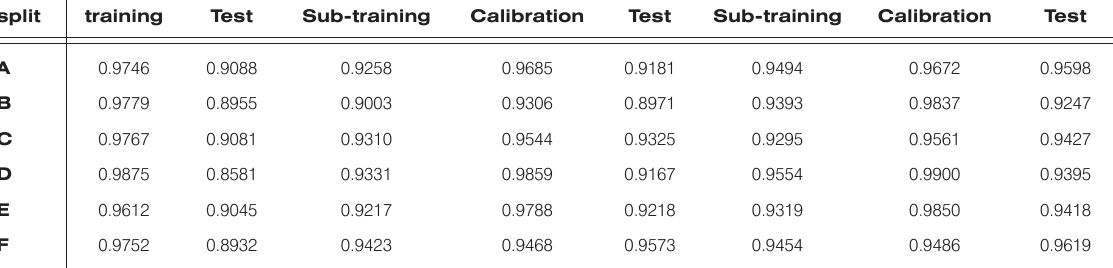
Classic system Balance of correlations without ATOMPAIR Balance of correlations with ATOMPAIR Correlation coefficients between experimental and predicted values of logIC50 for TIBO derivatives (SET